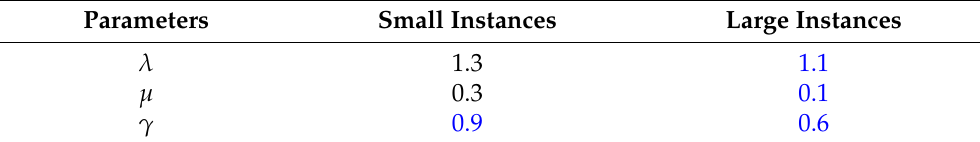
Table 3. Parameter values determined by irace for the C&W savings heuristic.